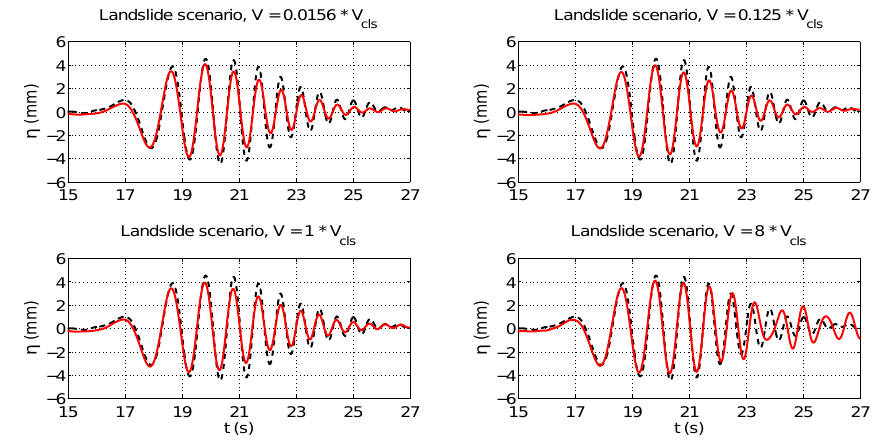
Fig. 6. Comparison of the numerical result (red solid line) with the experimental registration (black dashed line) at the control gauge 24S. Numerical model prediction is performed adopting gauge 7S as the inversion gauge, and using pre-event numerical computations carried out with 4 tentative landslide volumes. V cls is the volume of the so called correct landlide scenario.